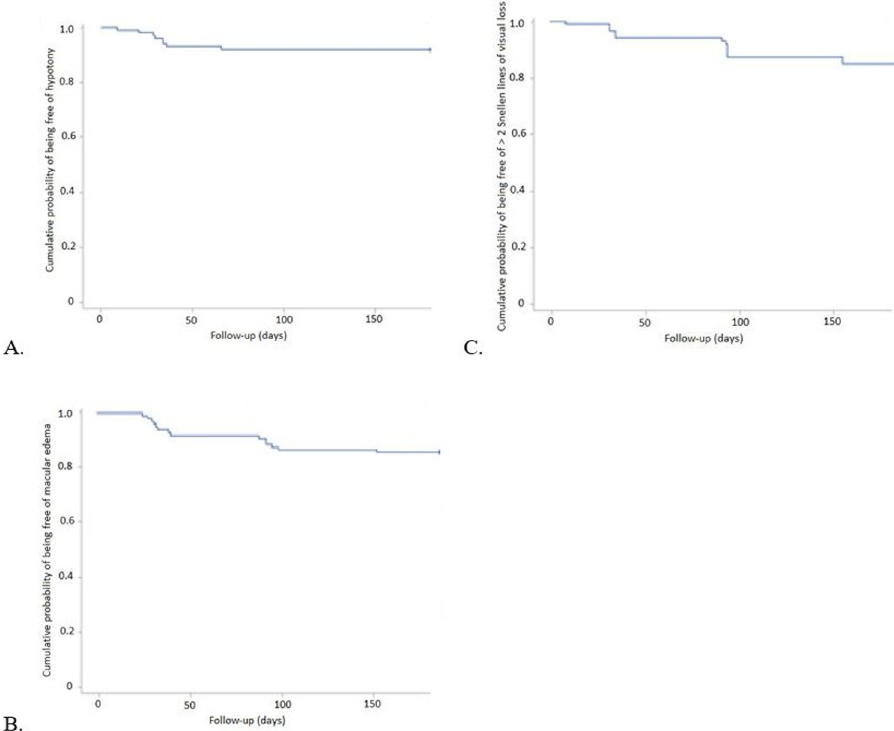
Fig 5. Scatter plot showing 6-month post-operative BCVA according to pre-operative BCVA. BCVA, best corrected visual acuity; logMAR, log minimum angle of resolution.